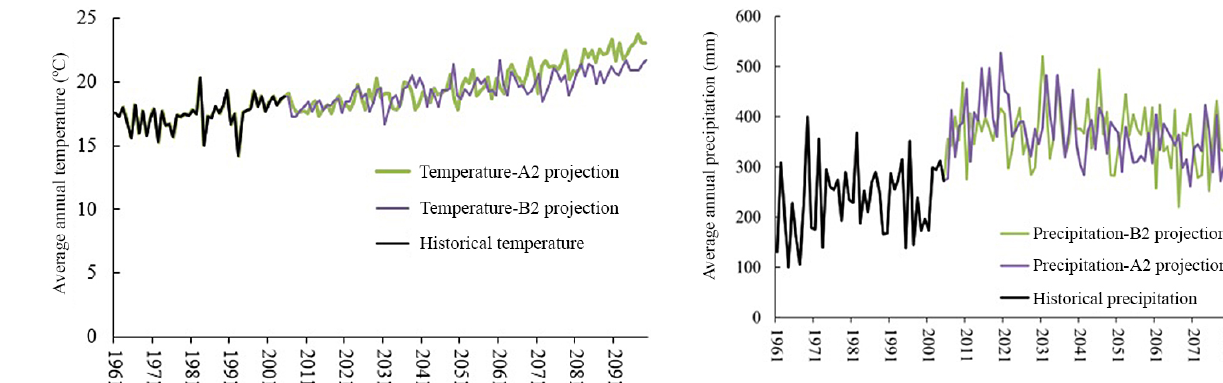
Figure 3. The average precipitation in A2 and B2 scenarios for the synoptic station in